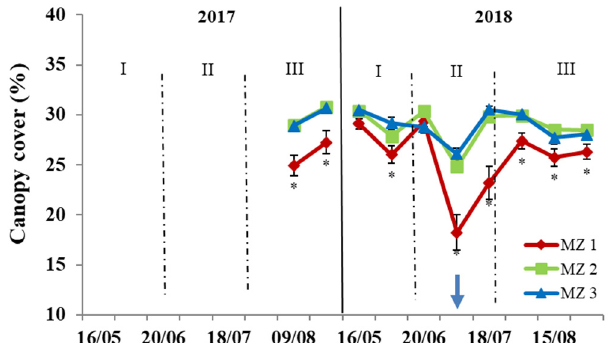
Figure 8. Seasonal course of canopy cover of the vines in the management zones (MZs) during 2017 and 2018. Measurement was conducted first by calculating NDVI in vine rows, then calculating the canopy coverage of every MZ. Each point is the mean of 22 random points created to account for spatial autocorrelation. The blue arrow indicates date of canopy trimming. Asterisks represent significant differences among MZs using ANOVA ( α = 0.05).